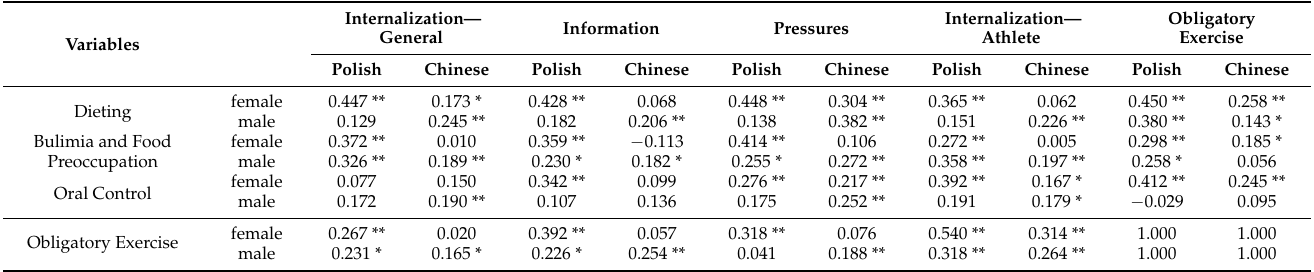
Table 2. Correlation analysis for all variables for the groups of Polish and Chinese.